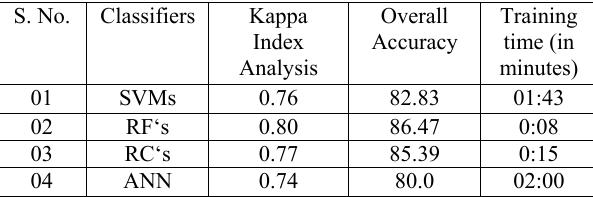
Table 2: Accuracy of the advanced machine learning classifiers In this study we have also recorded the area covered by